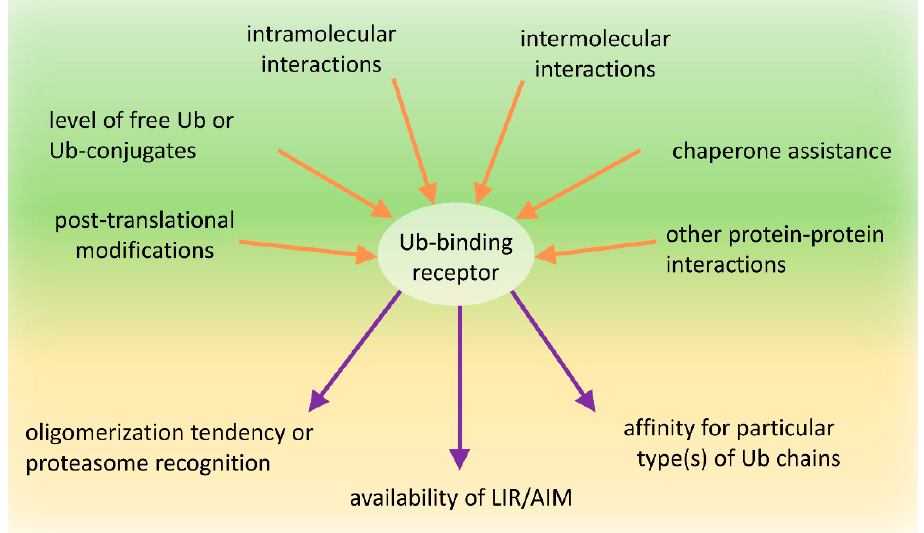
Figure 4. Schematic representation of factors affecting conformational changes and function of Ub-binding receptors. The impact of shuttling Ub-binding receptors on the fate of ubiquitinated targets relies on the combined effect of several regulatory factors acting on those receptors and affecting their oligomerization tendency or proteasome recognition, availability of AIM/LIR motifs for ATG8/LC3/GABARAP-family member proteins decorating isolation membranes, and the receptor affinity for particular type(s) of Ub chains. Factors influencing these choices include post-translational modifications, intramolecular, intermolecular homo-oligomeric, and hetero-oligomeric interactions of each domain present in these receptors, chaperone assistance, levels of available free Ub and Ub-conjugates and effects of other proteins and molecules interacting with Ub-binding receptors and affecting their conformational changes and/or function.